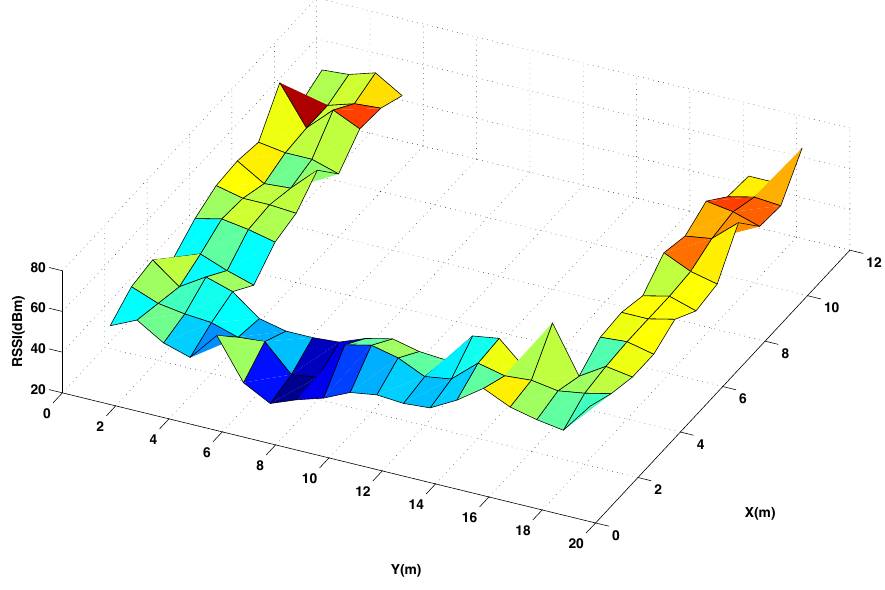
Figure 3. Radio map of RSSI for the original reference points in the testing area. Using channel CH11 and power level P3.